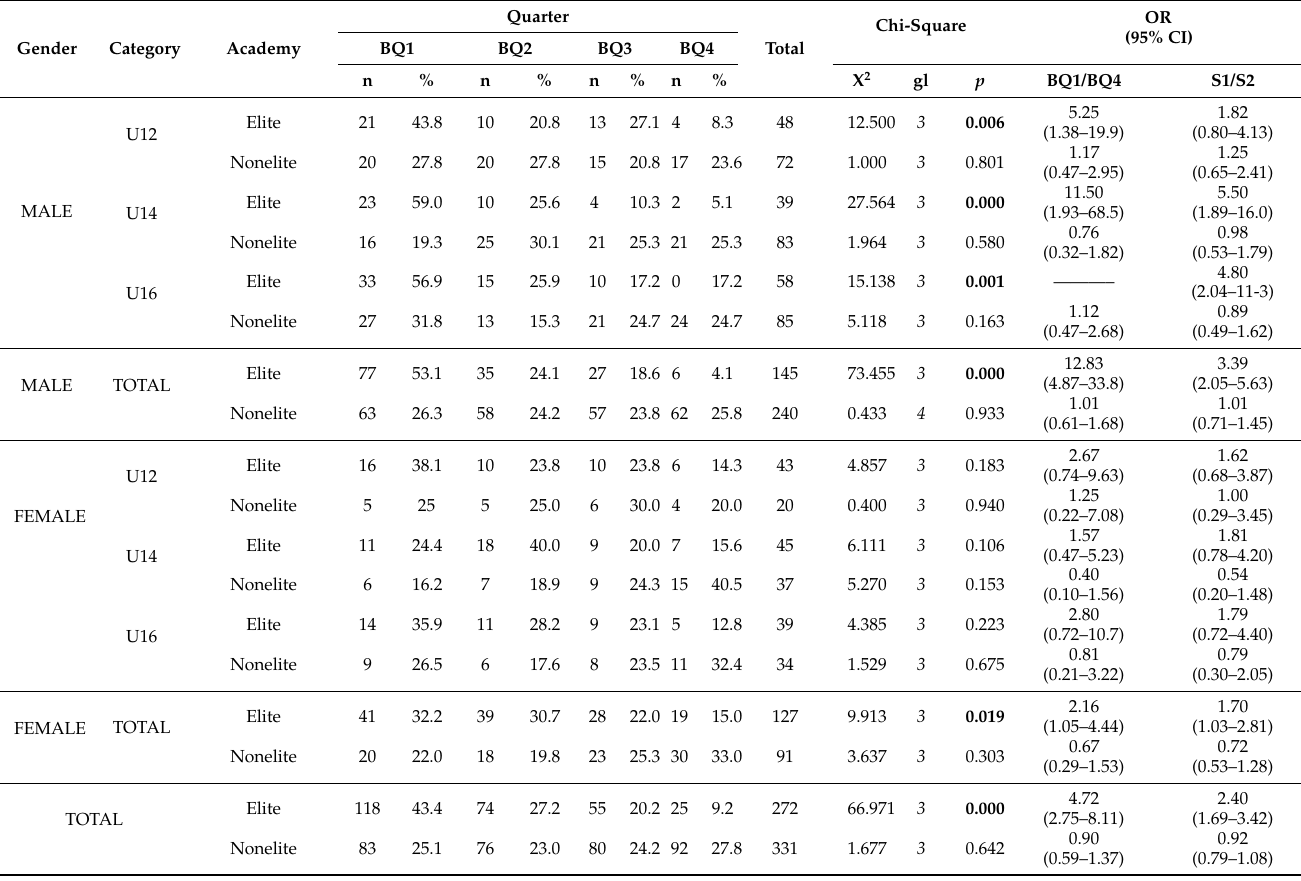
Table 2. Relative age effect in the different elite and nonelite academies, differentiating between